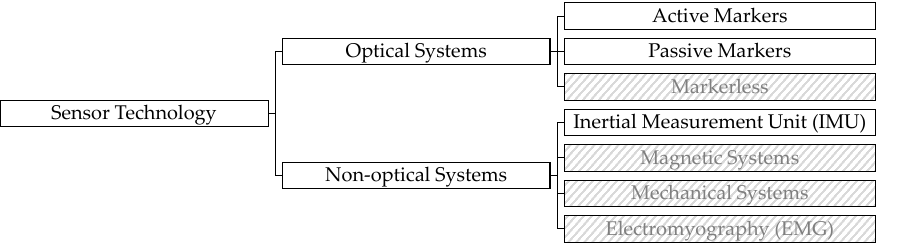
Figure 1. Sensor Technology for capturing human motions [26]. The selection covered in this contribution is